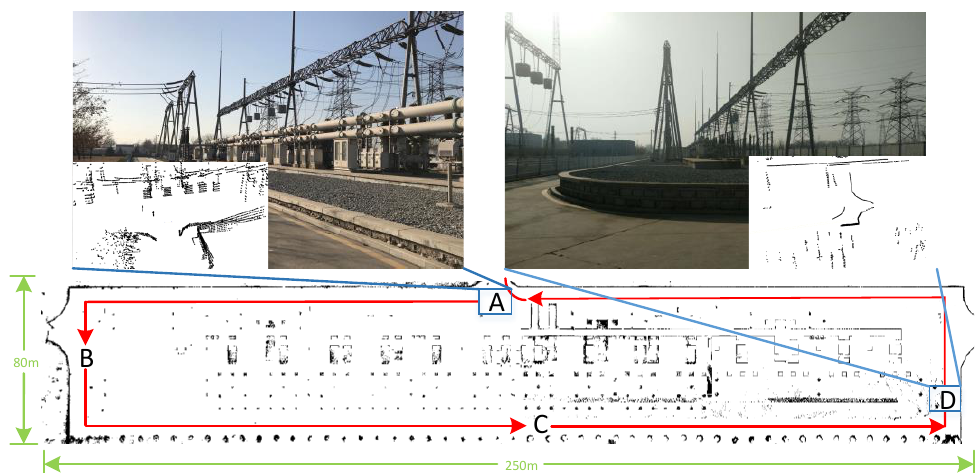
Figure 6. The plan and the environment of substation A.